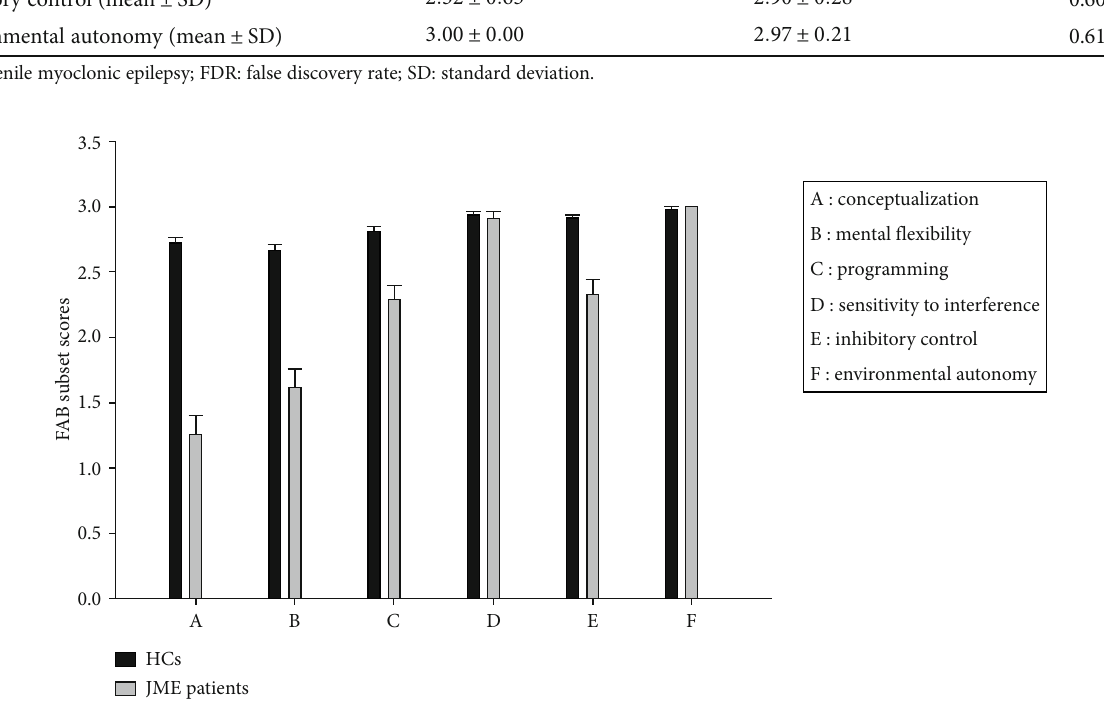
Figure 1: Comparison of FAB subset scores between JME patients and HCs. Table 3: Comparing FAB scores within JME patients controlling for age, sex, family history, disease duration, and multiple comparison. JME Less than a week ( n = 9 ) A week or more ( n = 22 ) FDR